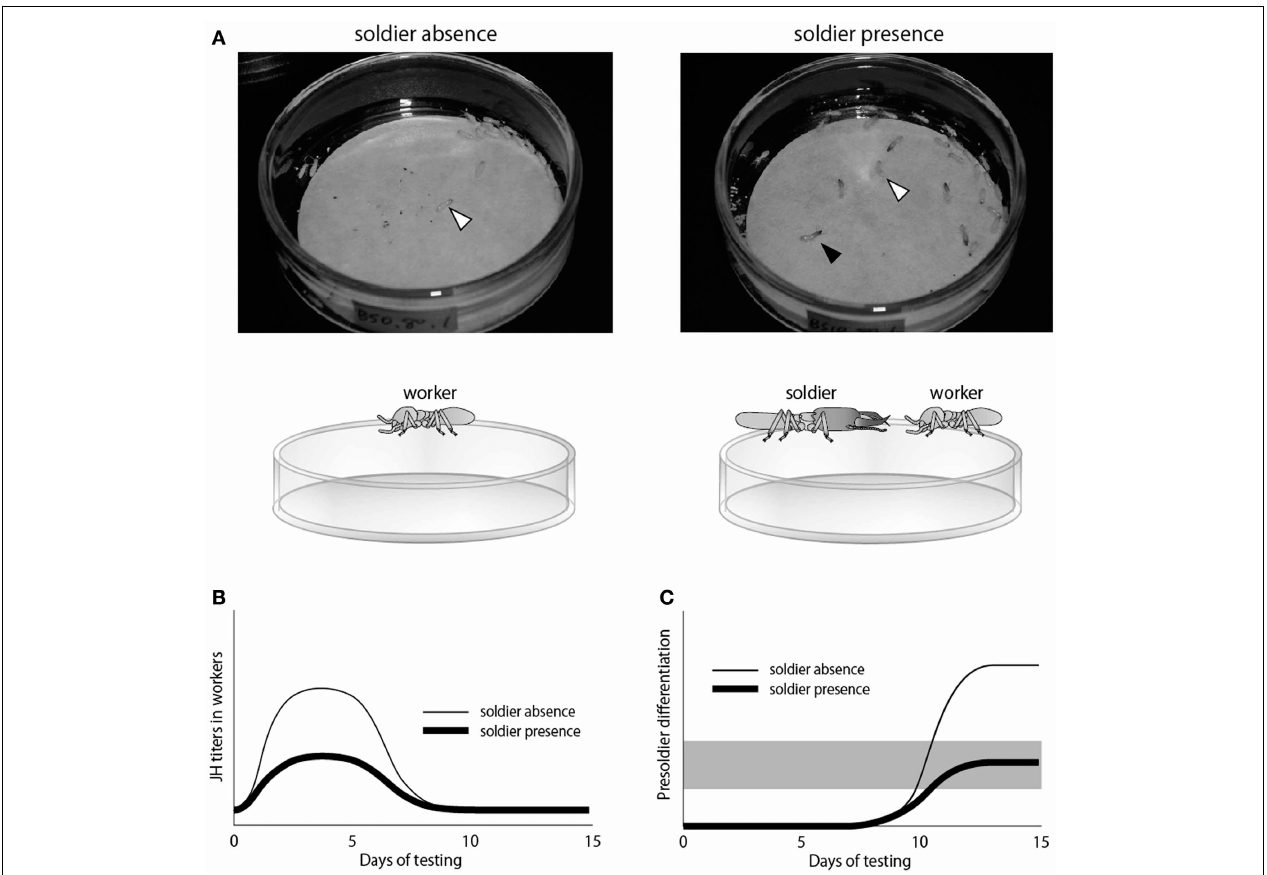
FIGURE 4 | A study examining the relationship between social interactions and JH titers in termites (Watanabe et al., 2011). (A) Experimental designs to obtain workers (white arrowheads) under the absence/presence of soldiers (black arrowhead) put on petri dishes with filter papers containing JHIII. The JH titers of workers reared by